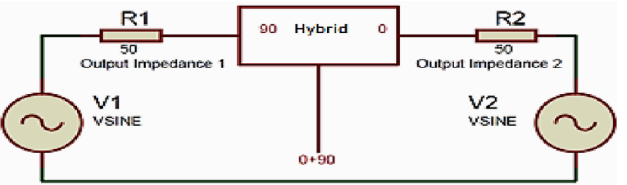
Figure 1. The equivalent circuit of a quarter-wavelength phased array with 90° difference feed under ideal conditions.